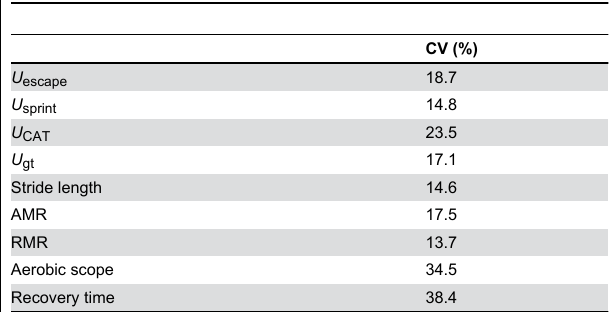
Table 1. Coefficients of variation of 9 variables measured in European sea